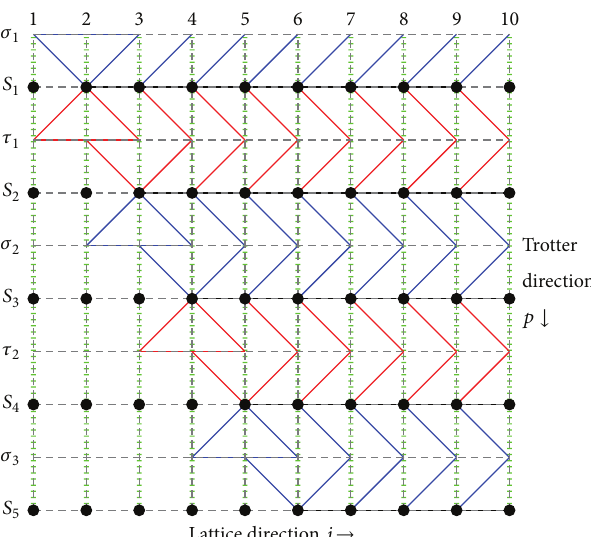
Figure 8: Lattice representation of a classical system equivalent to the general class of quantum